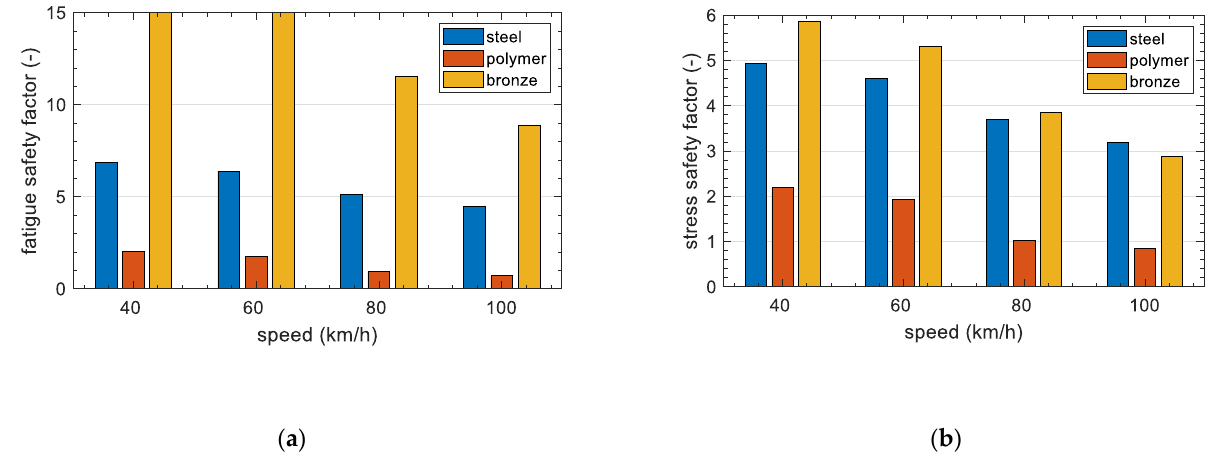
Figure 11. Calculated safety factors for the friction liner ( a ) fatigue safety factor-values less than 1 indicate failure before the design life is reached. Max. value = 15 (designed life of 1 10 9 cycles) ( b ) stress safety factor.